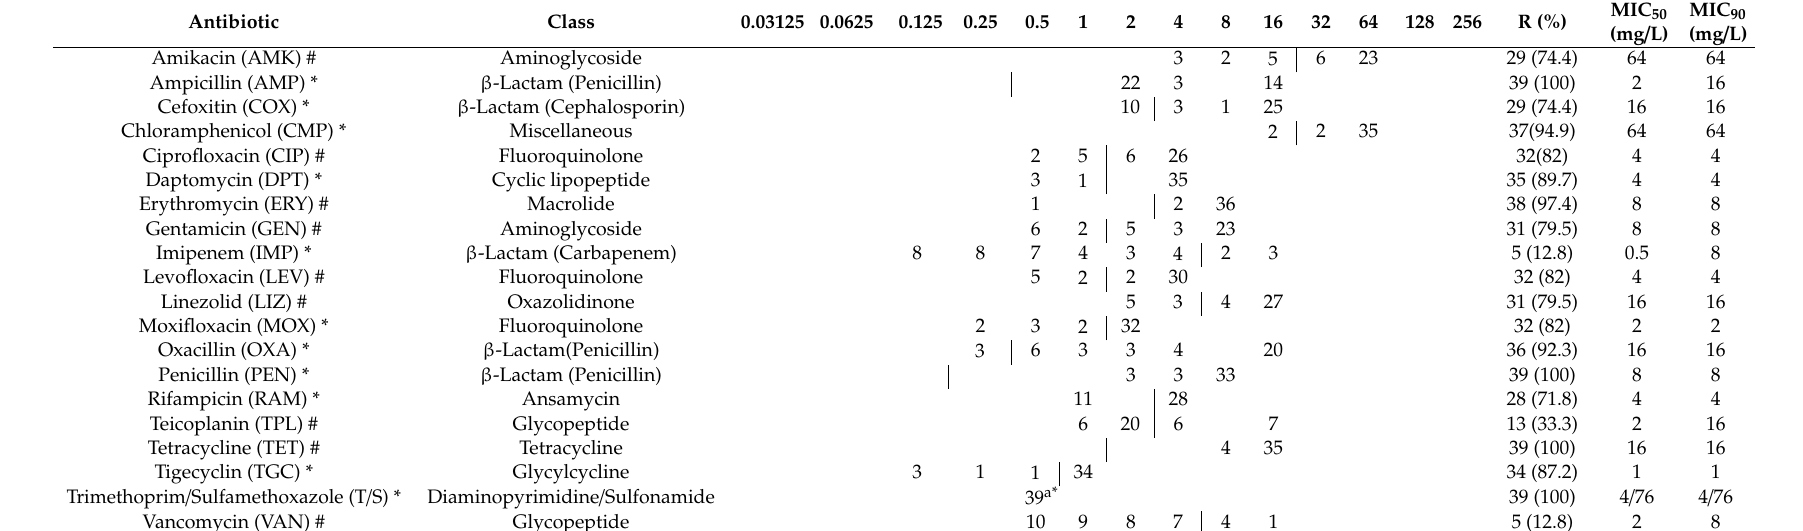
A thick black line indicates the break point between clinically sensitive and resistant strains; R—resistance rate. # EUCAST; *